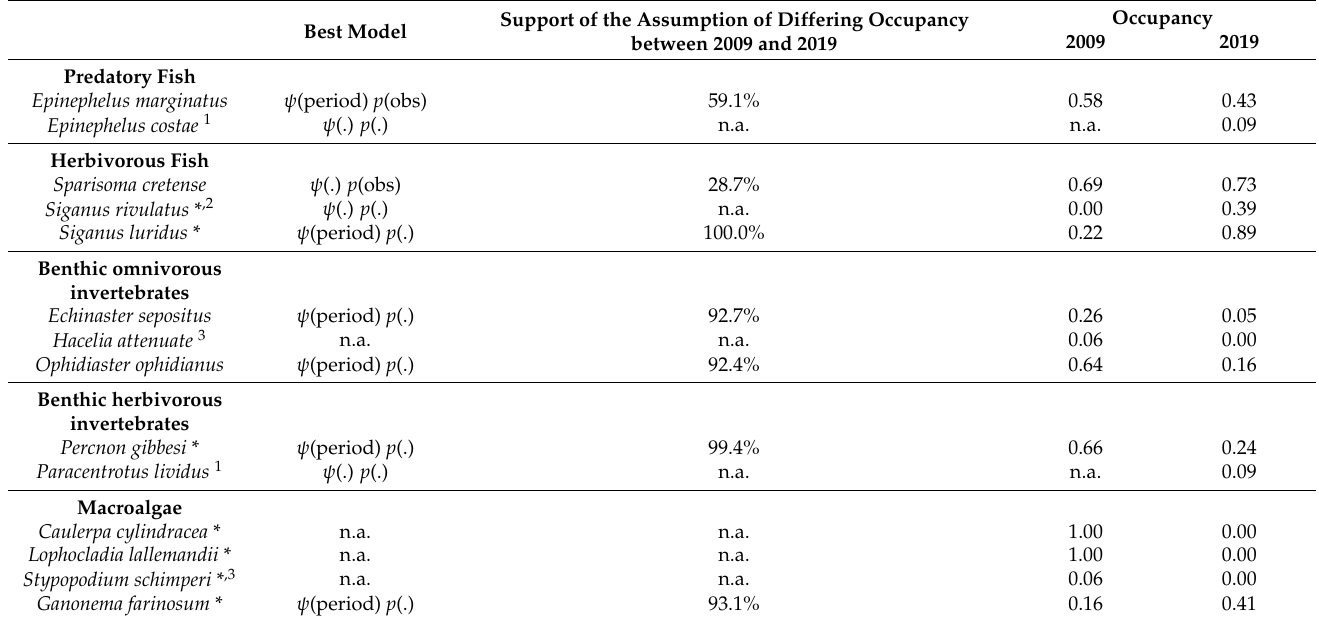
Table 3. Best occupancy model for each target species, support of the assumption of differing occupancy between 2009 and 2019, and estimated occupancy (model-averaged) for the two years ( ψ : occupancy; p : detection probability; obs: observer; n/a: not